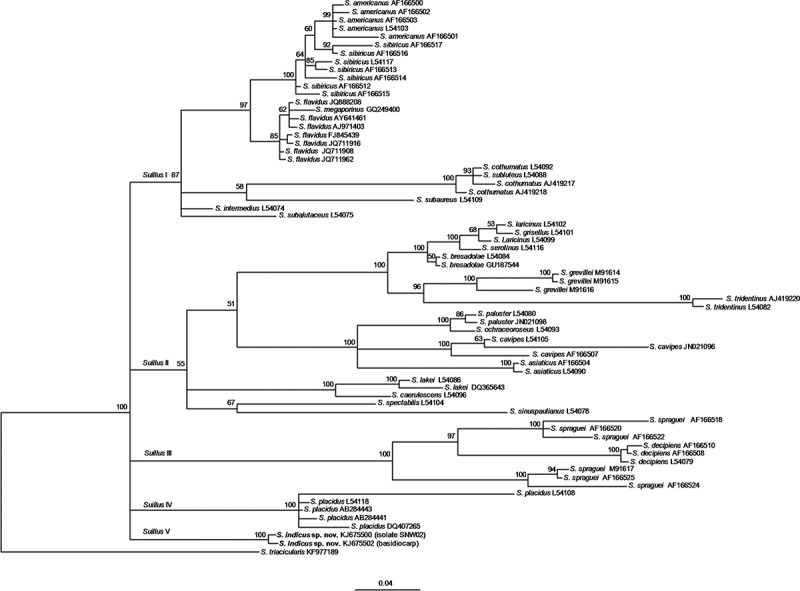
Bayesian tree showing the relationships between the internal transcribed spacer (ITS) sequences derived from the basidiome and isolate SNW02 (indicated in the brackets) of Suillus indicus (shown in bold) and those of related species retrieved from GenBank. Numbers at nodes stand for the posterior probability percentages (>50%) of the Bayesian analysis (outgroup: Suillus triacicularis).